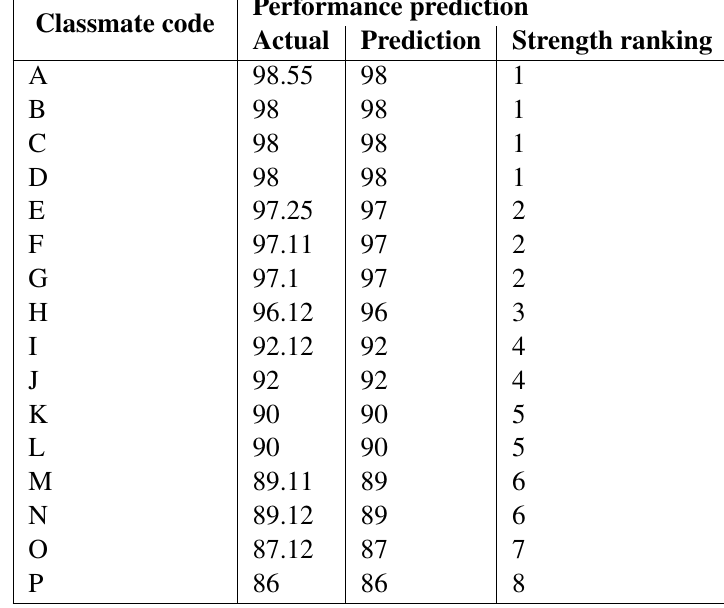
Table 3 List of the classification results of the merits of each school (region) and college sports